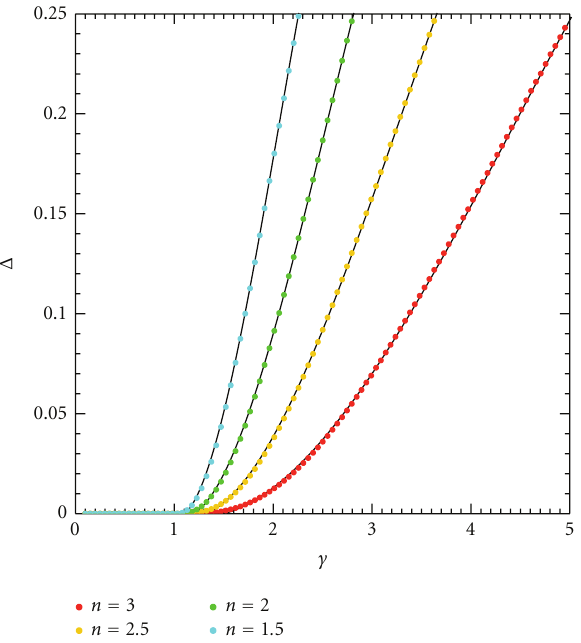
Figure 1: The fraction of mass lost per collision as a function of γ for several polytropic indices. The lines are third-order polynomial fits, whose coe ffi cients are given in Table 1.